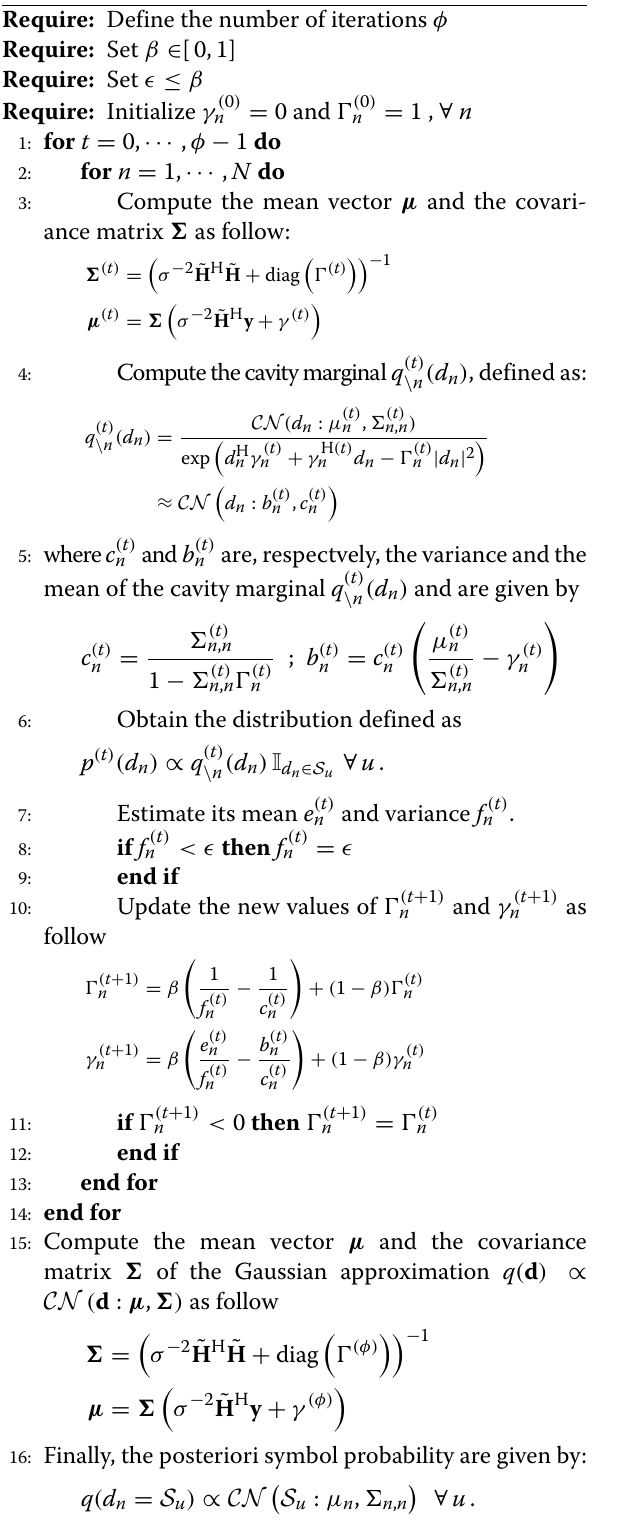
Algorithm 1 BEP Equalizer. The notation ( · ) ( t ) indicates the value of a given variable ( · ) at the t th